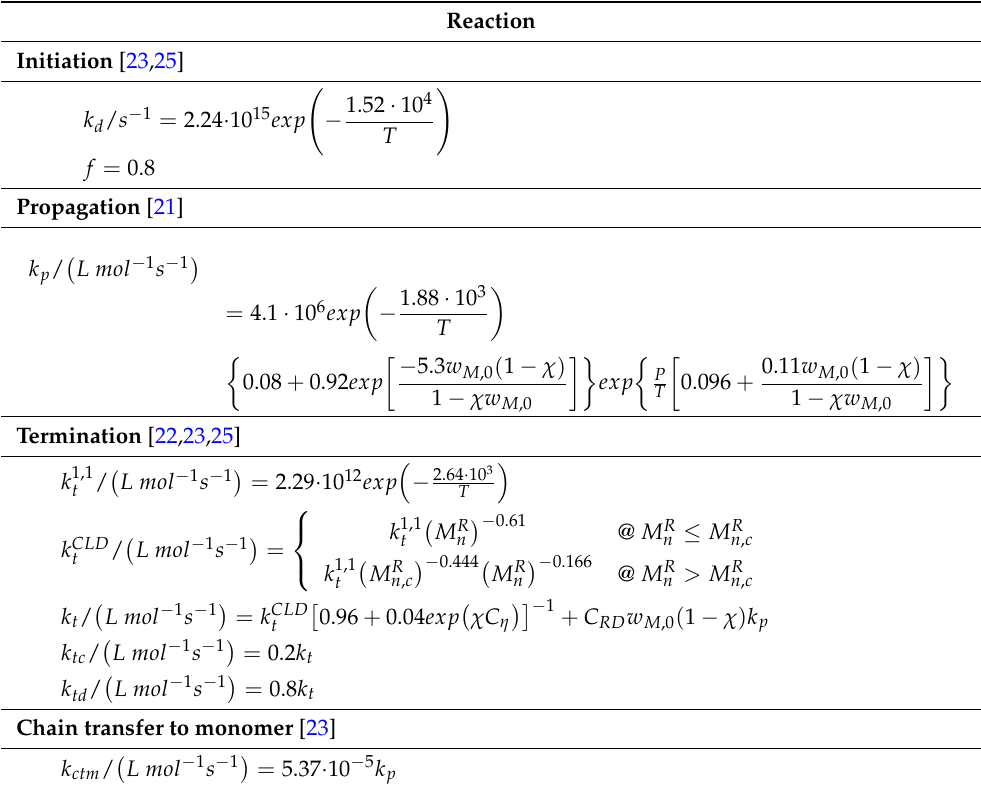
Table 3. Reaction rate coefficients used in the modeling of non-ionized MAA polymerization.